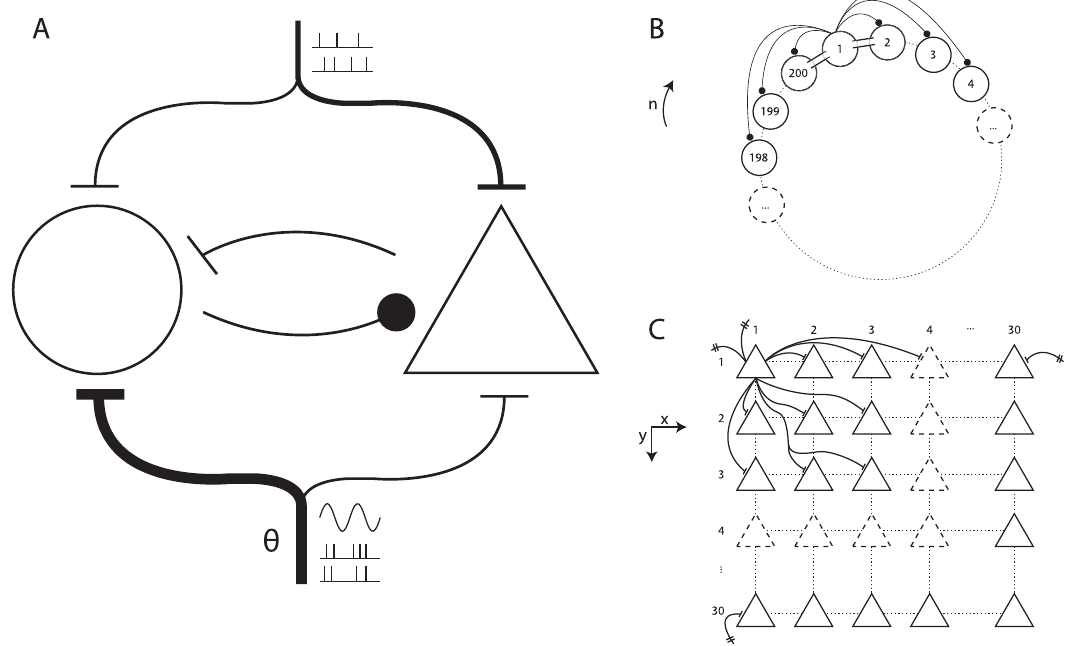
Figure 1. A patch of neocortex modelled by a network of interneurons coupled with a network of pyramidal cells. (A) The macroarchitecture of the model. Shown are the fast-spiking inhibitory interneuron network (circle, left), the pyramidal cell network (triangle, right), the cortical long-range afferent spike trains (top), and the theta-modulated subcortical afferent spike trains (bottom). (B) The ring-like structure of the interneuron model. Shown are some of the inhibitory synaptic connections (solid circles) and gap junctions (‘conduits’ between adjacent cells) for cell 1. (C) The two-dimensional structure of the pyramidal cell network. Shown are some of the excitatory synaptic projections from cell (1,1) to its neighbours. Note the projections to (30,1) and (1,30) are possible because the effective distance from (1,1) to those cells equals 1 (see Methods for details).